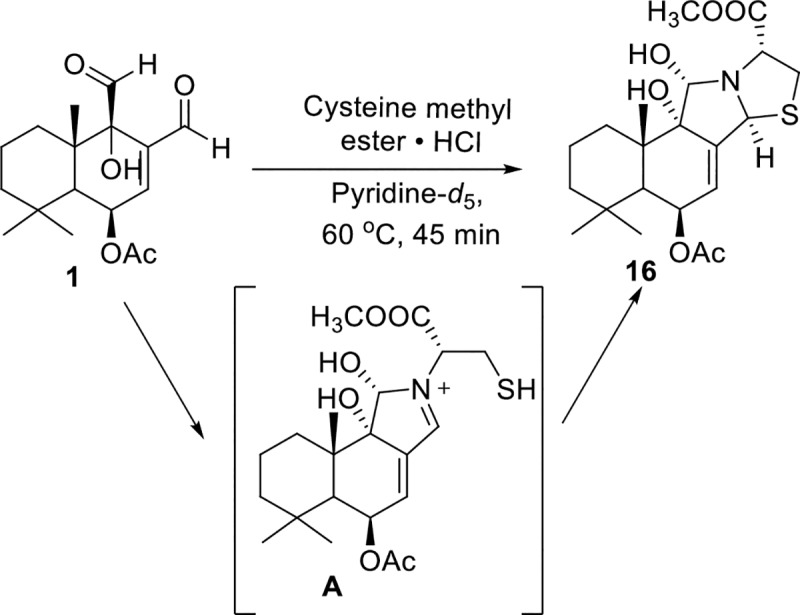
Reaction mechanism.Reaction mechanism of the reaction of 1 with L-cysteine methyl ester via a cationic azomethine A to form the thiazolidine 16.